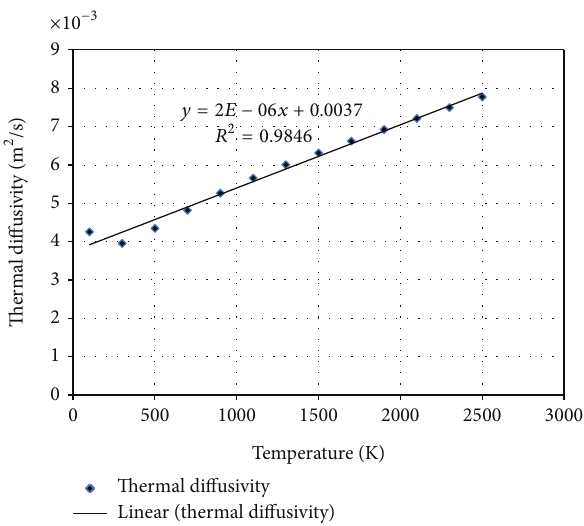
Figure 1: Thermal diffusivity of stainless steel AISI 304.